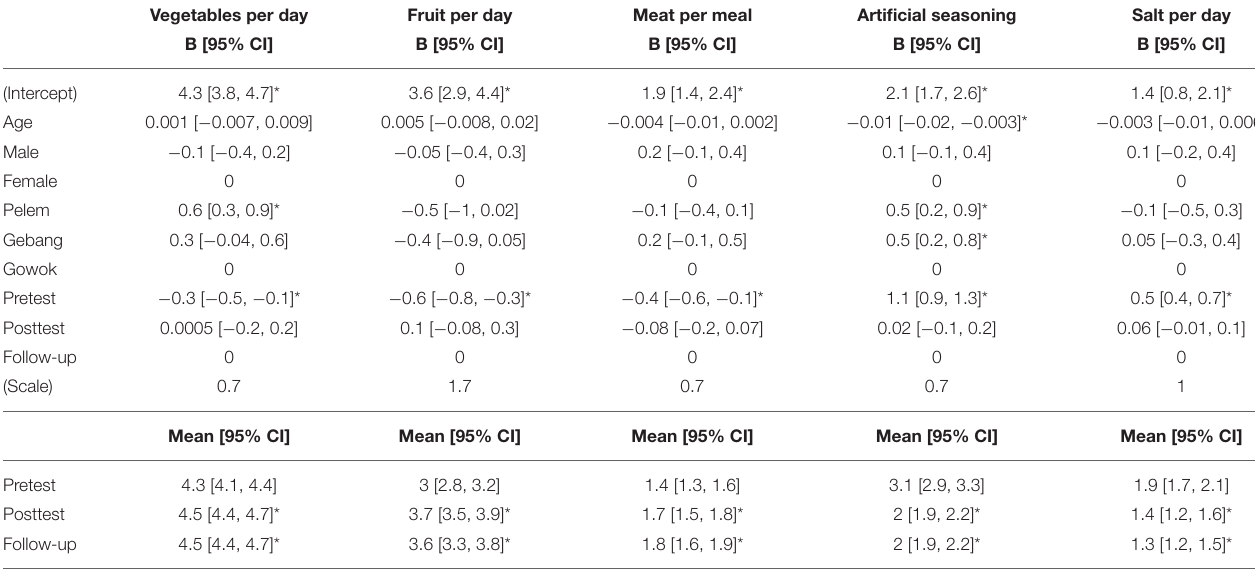
TABLE 2 | Regression coefficients and estimated marginal means of the amount of food, artificial seasoning, and salt intake. Vegetables per day Fruit per day Meat per meal Artificial seasoning Salt per day